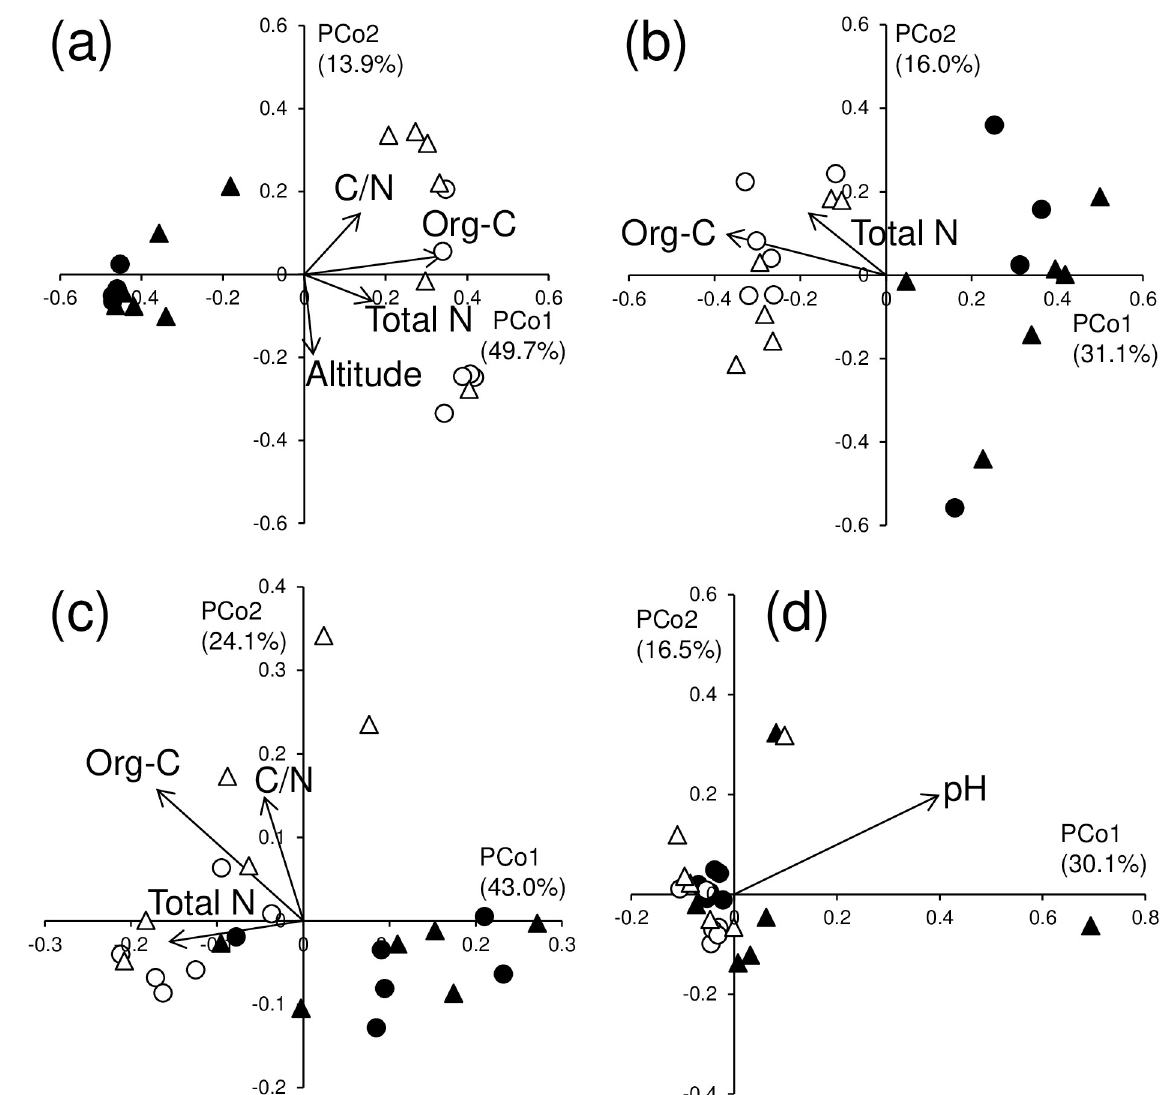
Fig 1. Principal coordinate analysis ordination of (a) bacterial DGGE profiles, (b) fungal DGGE profiles, (c) bacterial CLPP using the ECO plate, and (d) fungal CLPP using the SFN2 plate in the O and A horizons of Andosols and Cambisols. Filled triangle: A horizon of Cambisols; filled circle: A horizon of Andosols; hollow triangle: O horizon of Cambisols; hollow circle: O horizon of Andosols. Vectors for the significantly correlated ( p < 0.1) environmental variables are superimposed on the plot.